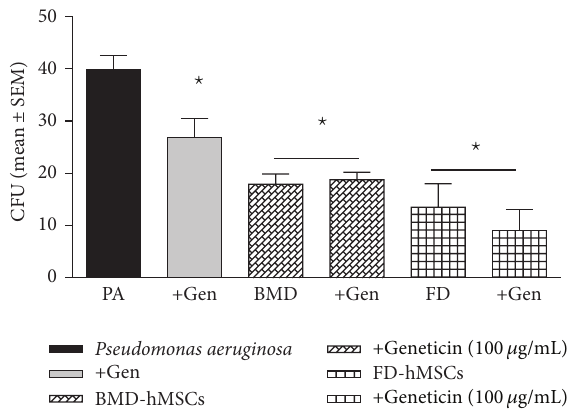
Figure 6: hMSC origin and impact on Pseudomonas aeruginosa growth. The availability of different hMSC sources provides the opportunitytoexplorewhethertheantimicrobialeffectivenessofthe hMSC supernatant was dependent on the tissue origin of the hMSC. LikethebonemarrowderivedhMSCs,hMSCsderivedfromadipose tissue significantly decreased Pseudomonas aeruginosa CFUs ( 𝑃 ≤ 0.05 ) and enhanced geneticin (100 𝜇 g/mL) effectiveness ( 𝑃 = 0.08 , 𝑛 = 3 ). PA = Pseudomonas aeruginosa growth without treatment. Geneticin = treatment with the antibiotic geneticin, +hMSCs = treatment with hMSC derived supernatant, and Both = treatment with both hMSC supernatants and geneticin. hMSC supernatants enhance antibiotic effectiveness against Pseudomonas aeruginosa